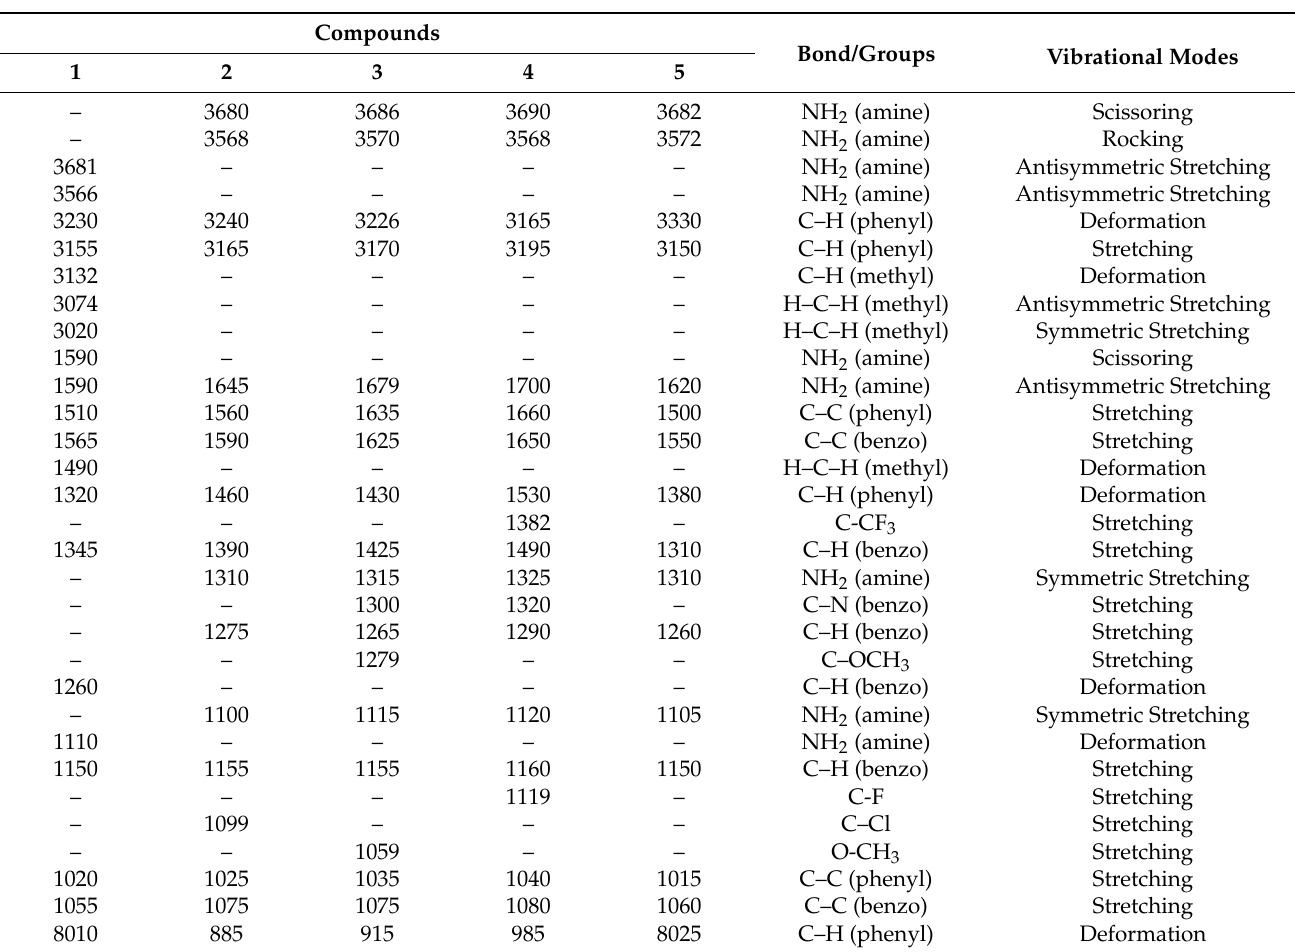
Figure 7. IR spectrum of 1 . Table 5. Theoretically calculated vibrational frequencies and vibrational modes of 1 to 5